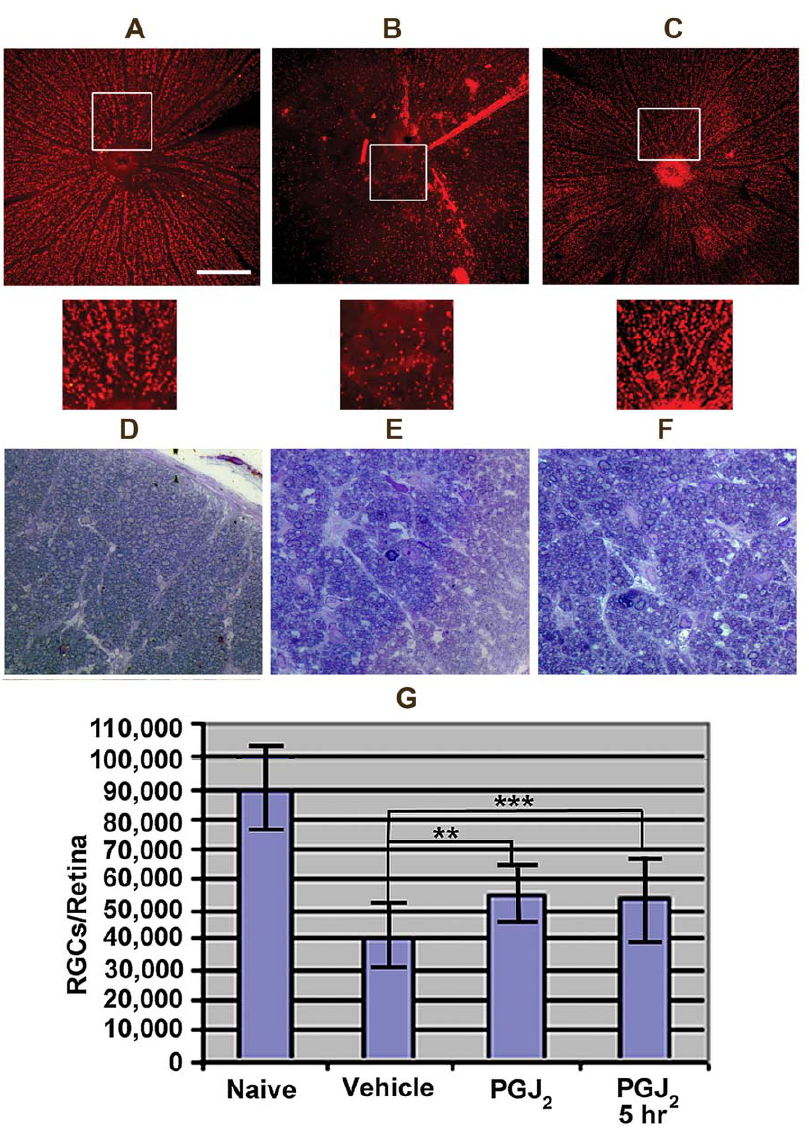
Figure 6. PGJ 2 -associated neuroprotection of ON and RGCs 30 days post-infarct. A–C: Brn3a stained retina flatmounts. Rectangles indicate high magnification retinal regions shown as insets immediately below. A. Control retina. Brn3a( + ) RGCs are arranged evenly across the retina. B. Retina from an rAION-induced, vehicle treated animal. There is a regional loss of Brn3a( + ) RGCs. C. Retina from an rAION-induced, PGJ2-treated animal. The retina shows smaller areas of RGC loss (compare C with B). D–F: Toluidine blue stained ON cross-sections. D. Naı¨ve ON. Axons of varying diameters are packed into thinly septated (Sep) bundles (AxB). E. rAION-induced, vehicle treated animal. There is axonal loss, and increased septal thickness (Sep). F. rAION-induced, PGJ2-treated animal. Axonal loss is reduced, with thinner septae (Sep). G. Stereological quantification of RGCs in naı¨ve, vehicle treated, and animals administered PGJ 2 either immediately after or 5 hours post-infarct. Significance (ANOVA, p , 0.05). Scale bars: A: 500 m m. D: 50 m